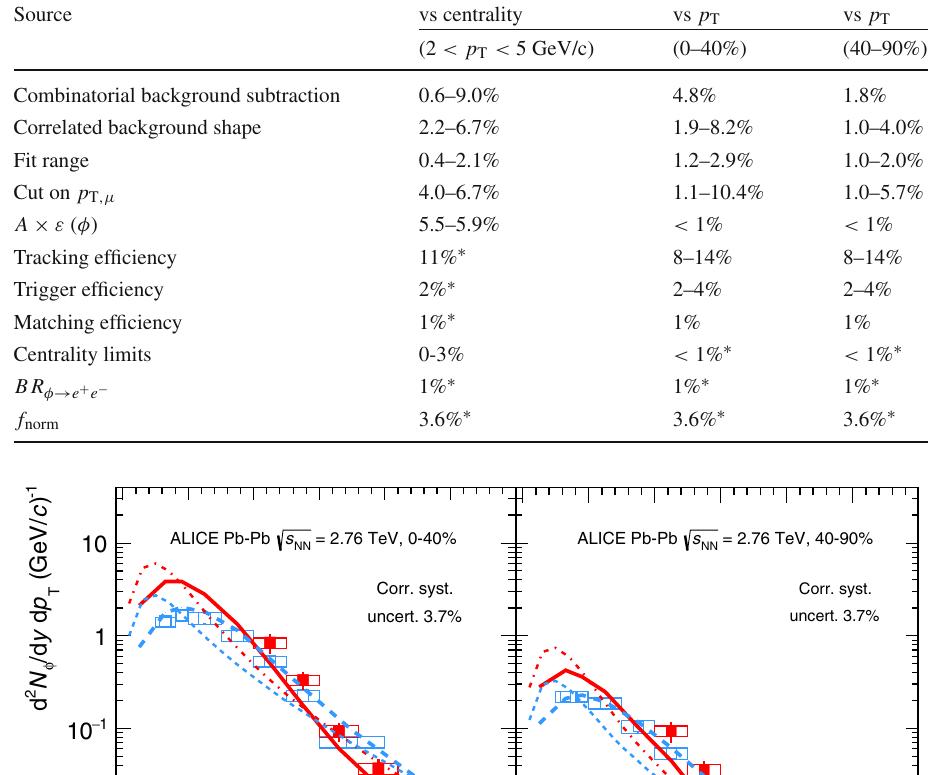
Fig. 6 Top panel: comparison between the φ yield as a function of p T with the EPOS 3.101 [26,58,59] and HIJING 2.0 [60] event generators, at forward and midrapidity [6], for 0–40% (left) and 40–90% centrality (right). The same scale factors applied to data were also used for the models. The transparent boxes represent the uncorrelated systematic uncertainties at forward rapidity and the total systematic uncertainties (including correlated and uncorrelated components) at midrapidity. Lower panels: ratios between the measured yields and the calculations by EPOS and